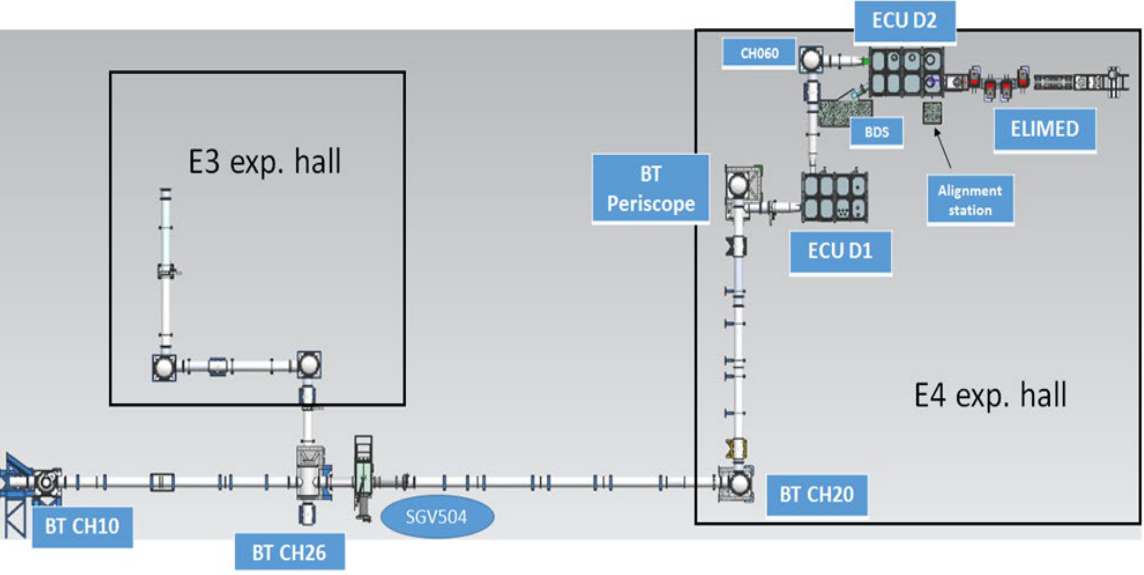
Figure 2. Overview of the L3 Beam Transport (BT) system. CH10 is the first chamber underneath the L3 compressor; CH26 is a switchyard chamber used to deliver the L3 beam to the E3 hall. SGV504 is the Safety Gate Valve isolating the L3 BT path leading to the E4 Hall.